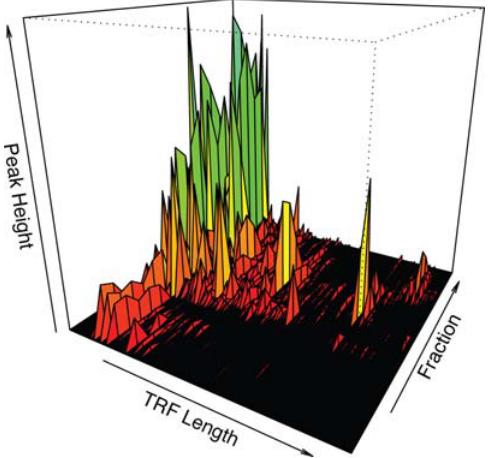
Figure 1. Plot of GC-TRFLP data for a soil sample indicating TRFLP results for CsCl gradient fractions containing DNA of different G + C content. Peaks are colored based on height to increase contrast between peaks.